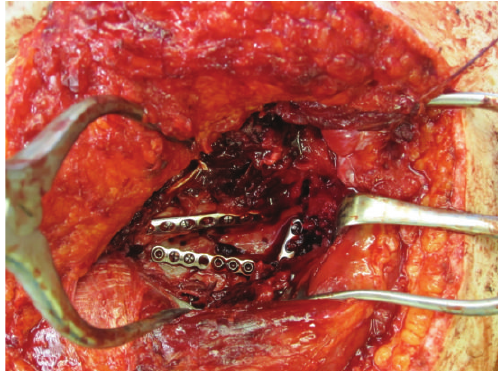
Figure 11: Intraoperative photograph demonstrating three small fragment plates positioned to maintain reduction of the scapular fracture.